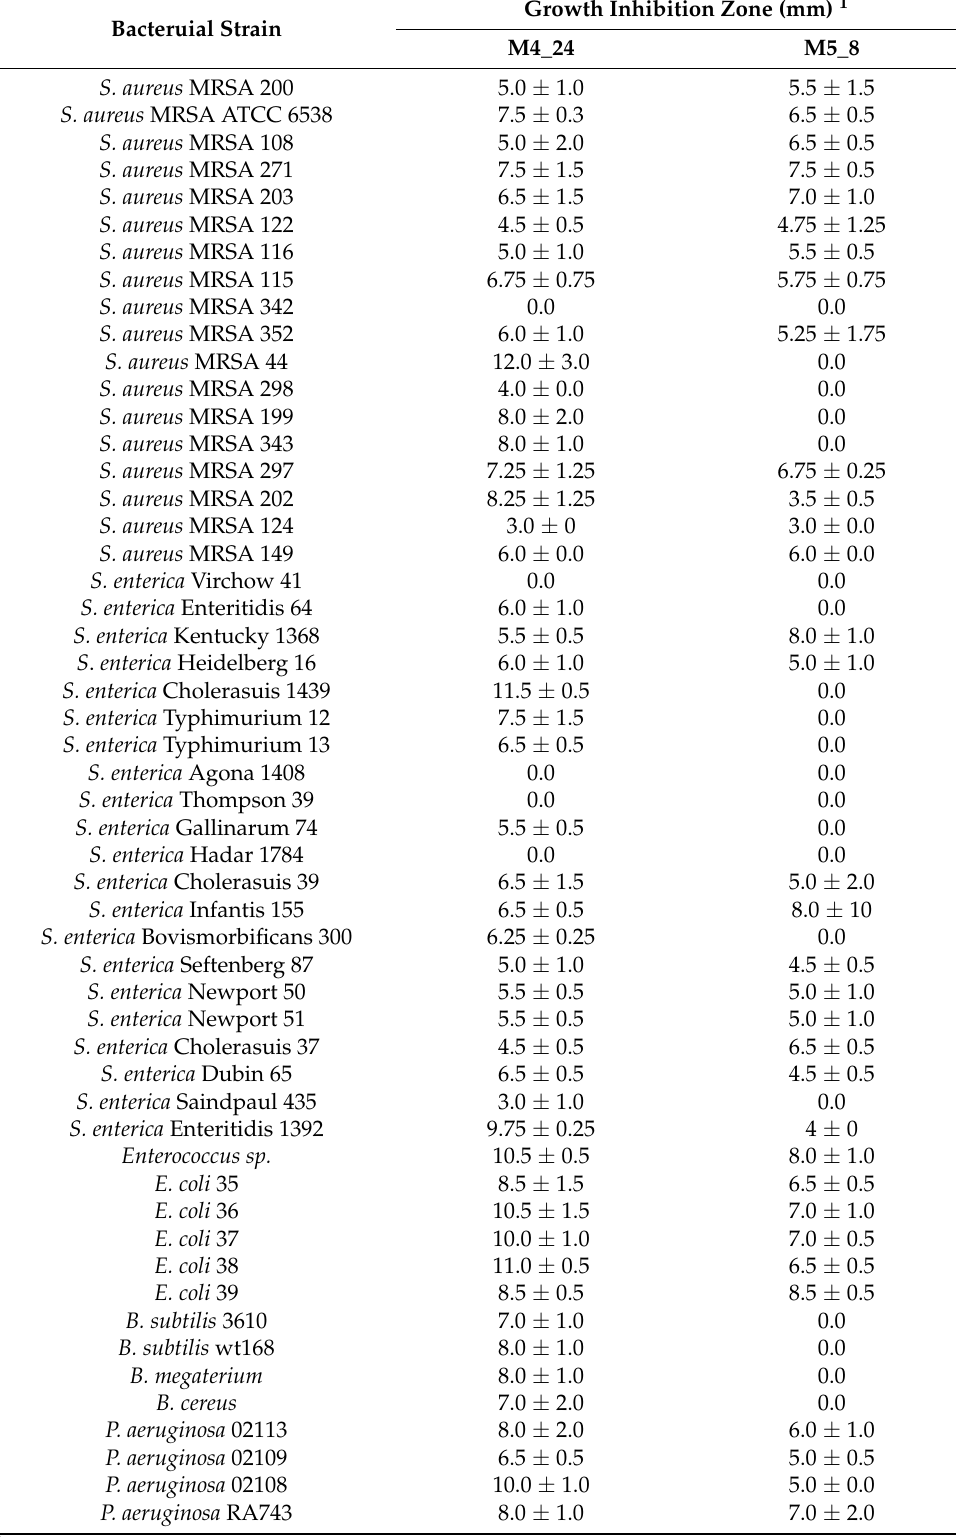
Table 3. Effects of Streptomyces M4_24 and M5_8 isolates on growth inhibition of bacterial strains. The width of the inhibition zone was measured in the streak-test after 48 h of